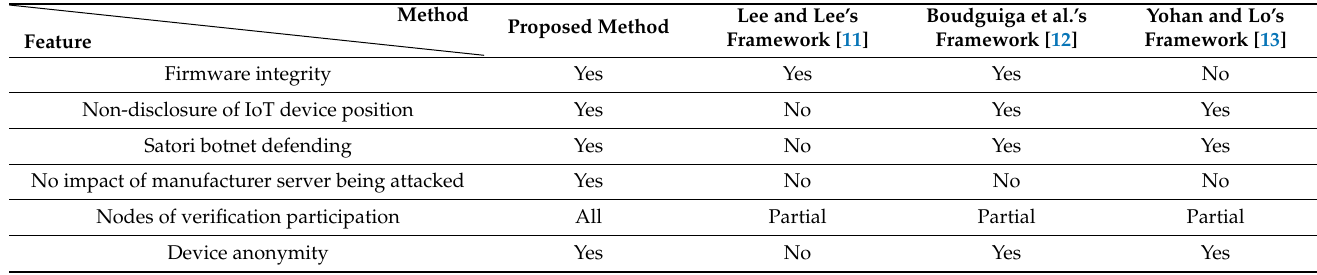
Table 2. Functionality comparisons.